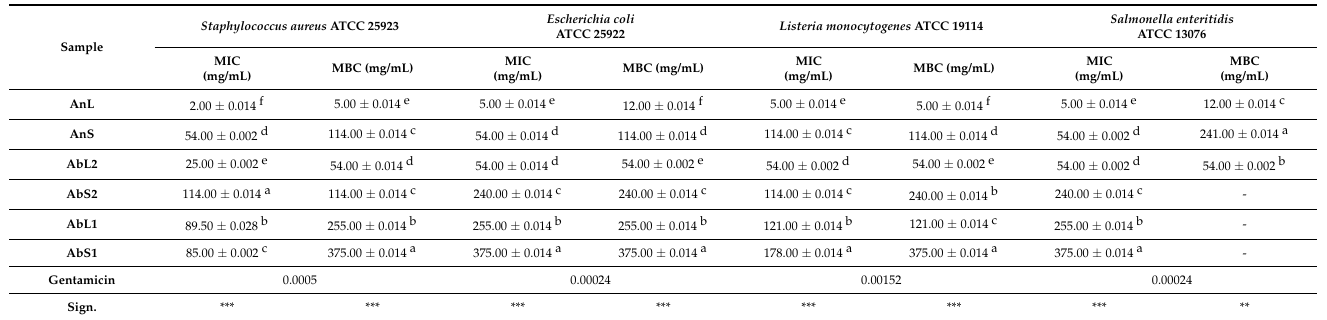
Table 4. Assessment of the minimum inhibitory concentration and the minimum bactericidal concen- tration values of the wormwood ethanolic extracts from different growing years.